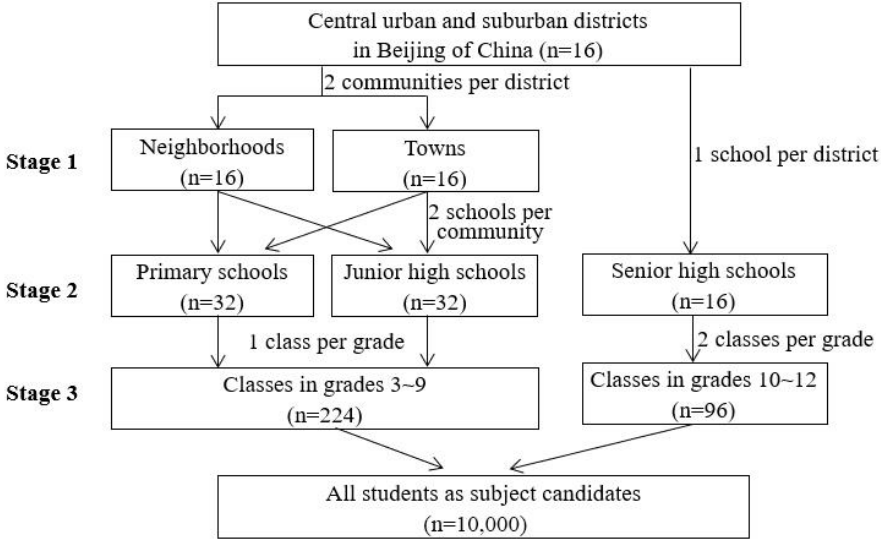
Figure 1. Multi-stage stratified cluster sampling process of the study.